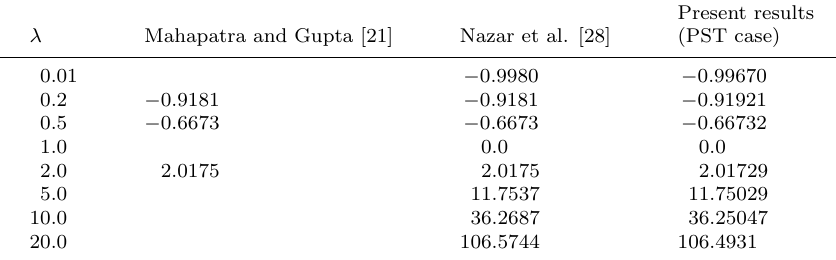
Present results